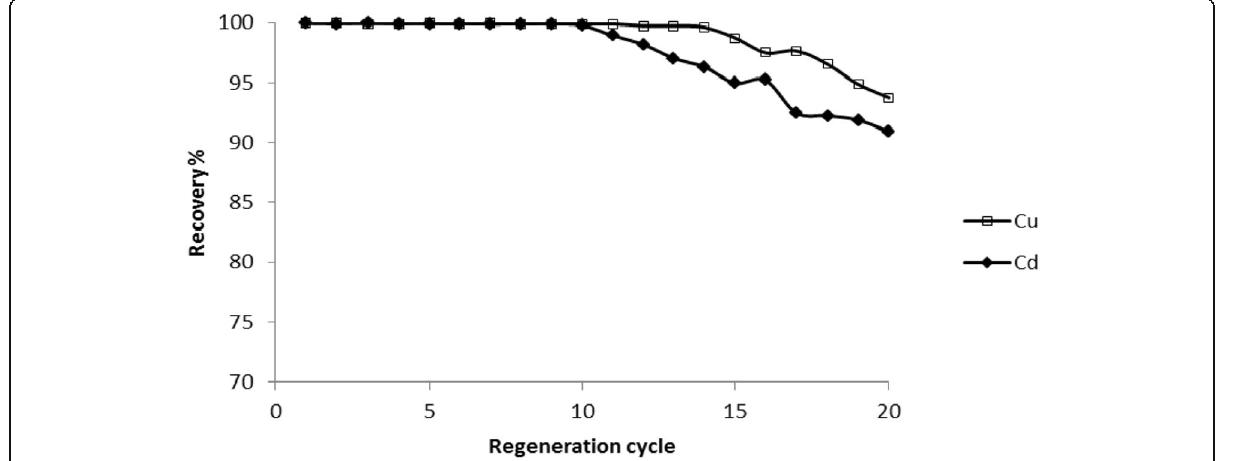
Fig. 5 Reusability of the columns for Cu(II) and Cd(II) recoveries